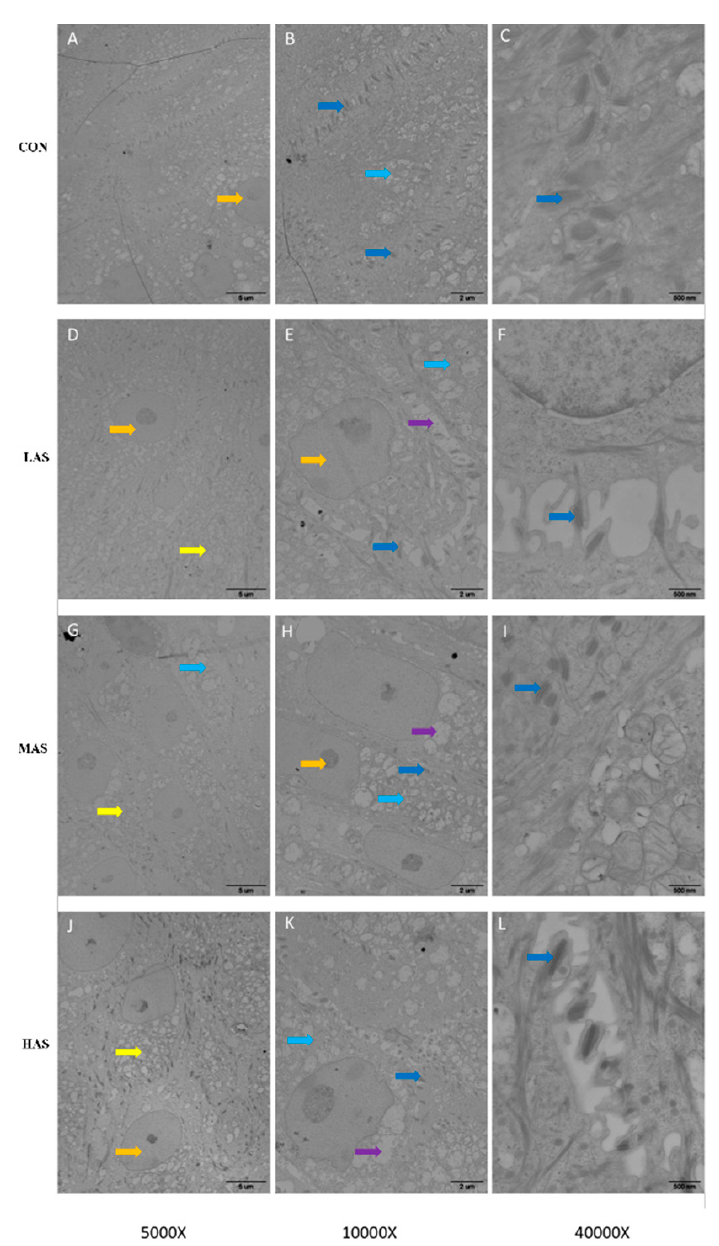
Figure 9. Different forms of stratum corneum cells disruption in the HAS group. (sloughing of the corneum, crack and budding). The epithelial keratinocytes of rumen epithelium were exfoliating, necrotic ( A , B , shown by arrows), budding ( C , shown by arrows) and forming large fissures ( D , shown by arrows).